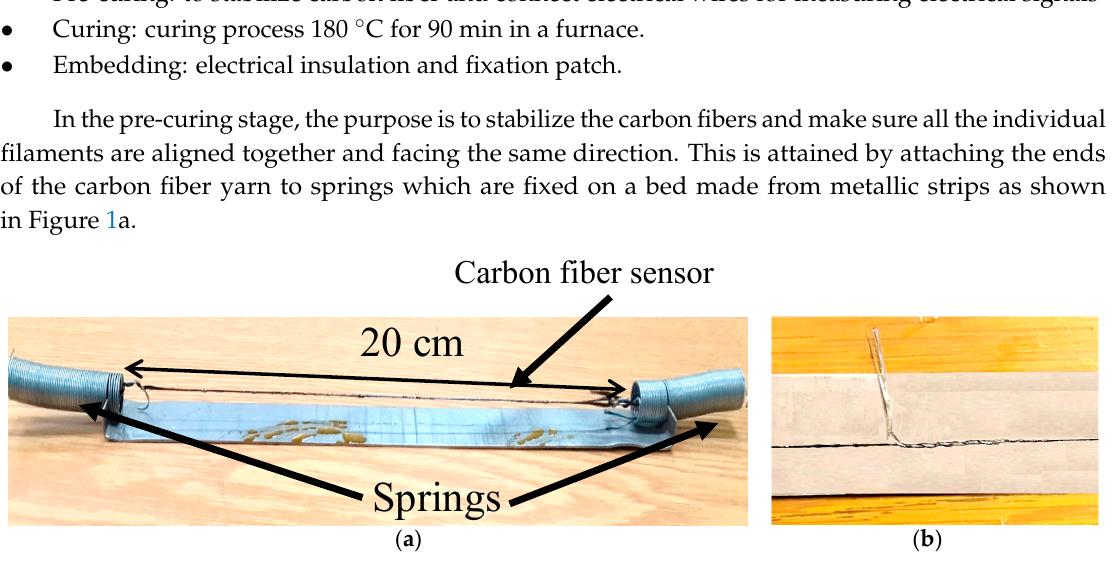
Figure 1. ( a ) Carbon fiber with springs on a metallic bed; ( b ) electrical connections.